Question: Give a one-sentence summary of this figure.
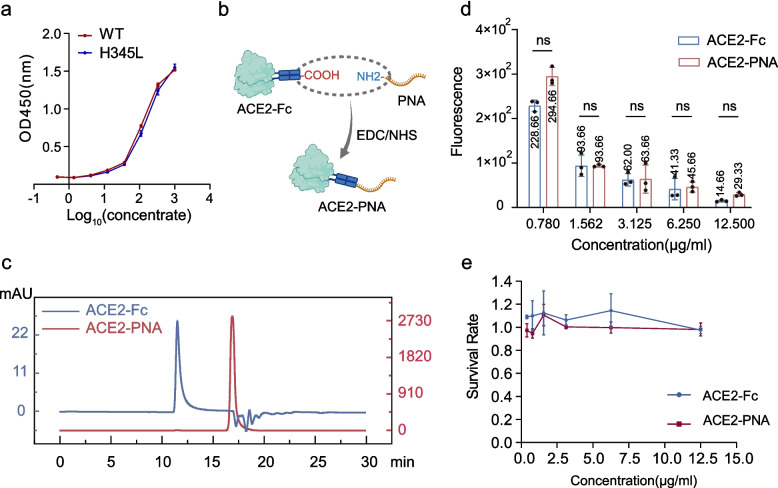
Answer: ACE2-PNA Retains the Virus-Neutralizing Activity of ACE2-Fc. a Binding affinity of wild-type ACE2-Fc and ACE2-Fc(H345L), shortened as WT and H345L respectively in figure, to the SARS-CoV-2 spike protein assessed by ELISA. 96-well plates were coated with SARS-CoV-2 spike protein (1 μg/mL), followed by incubation with serially diluted ACE2 proteins for 2 h. Bound protein was detected using an HRP-conjugated goat anti-human IgG (H + L) secondary antibody. Absorbance was measured at 450 nm. Data are mean ± SD ( n = 3). b Schematic of EDC/NHS-mediated covalent conjugation of ACE2-Fc and CPP-PNA. EDC activates carboxyl groups on ACE2-Fc to form O-acylisourea intermediates, which react with NHS to generate stable NHS-esters. Upon adjustment to weakly alkaline pH (7–8), primary amines on CPP-PNA undergo nucleophilic attack to form stable amide bonds, yielding the ACE2-PNA conjugate. c RP-HPLC chromatogram of the ACE2-PNA reaction mixture following purification by ultrafiltration using a 50 kDa MWCO membrane. The ACE2-PNA conjugate displayed a dominant, symmetric peak at approximately 16.9 min, accounting for 98.99% of the total peak area. As a control, ACE2-Fc eluted at approximately 11.5 min. d Neutralization of SARS-CoV-2 spike pseudovirus by ACE2-Fc or ACE2-PNA. A fixed amount of SARS-CoV-2 spike-pseudovirus carrying a luciferase reporter gene was incubated with the indicated concentrations of ACE2-Fc or ACE2-PNA at 37 °C for 1 h, then added to hACE2 -HEK293T cells. The medium was replaced after 8 h, and luciferase activity was measured 72 h post-infection. Higher fluorescence intensity indicates greater pseudovirus entry. Data are mean ± SD ( n = 3). Statistical significance was determined by multiple unpaired Student's t-tests. Groups labeled "ns" indicate no statistically significant difference (P > 0.05). e CCK-8 assay of hACE2 -HEK293T cells treated with the indicated concentrations of ACE2-Fc or ACE2-PNA. Following incubation, CCK-8 solution was added and absorbanc